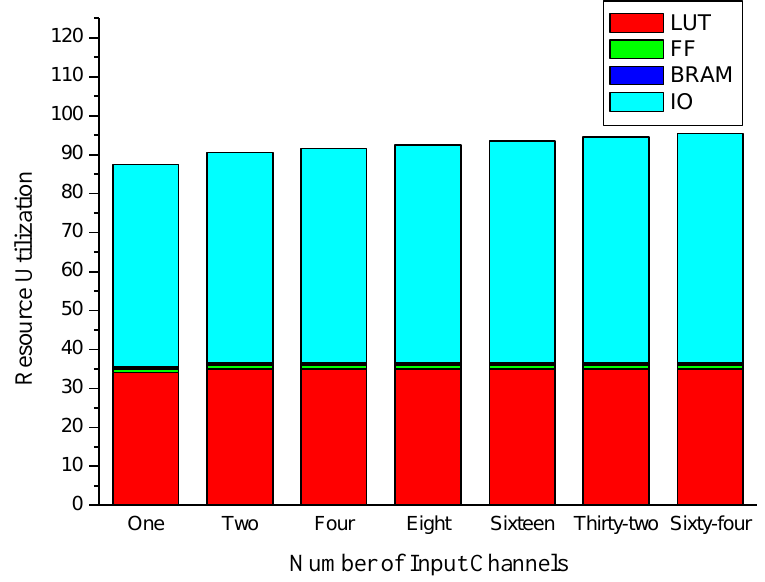
Figure 9. Comparative resource utilization for different numbers of